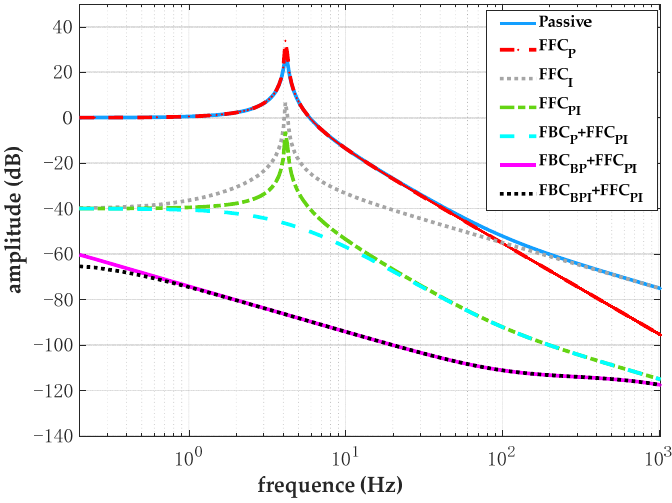
Figure 2. The velocity transmissibility of one DOF AVRS in the vertical direction in different situations: Passive, FF P control FFC P , FF I control FFC I , FF PI control FFC PI , FB P control based on FF PI control FBC P + FFC PI , FB big P gain control based on FF PI control FBC BP + FFC PI , FBC big P gain plus I control based on FFC PI control FBC BPI + FFC PI .